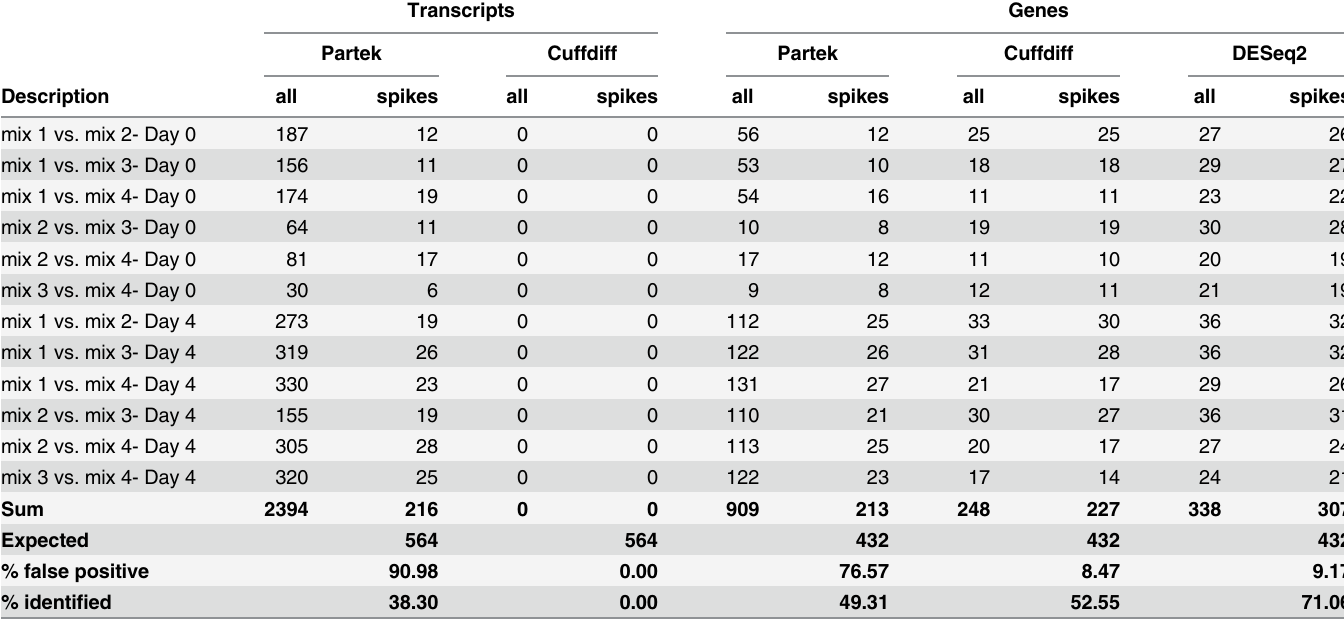
Table 2. Number of differentially expressed transcripts and genes among the mixes, as identified using various bioinformatics tools using Gen- code+